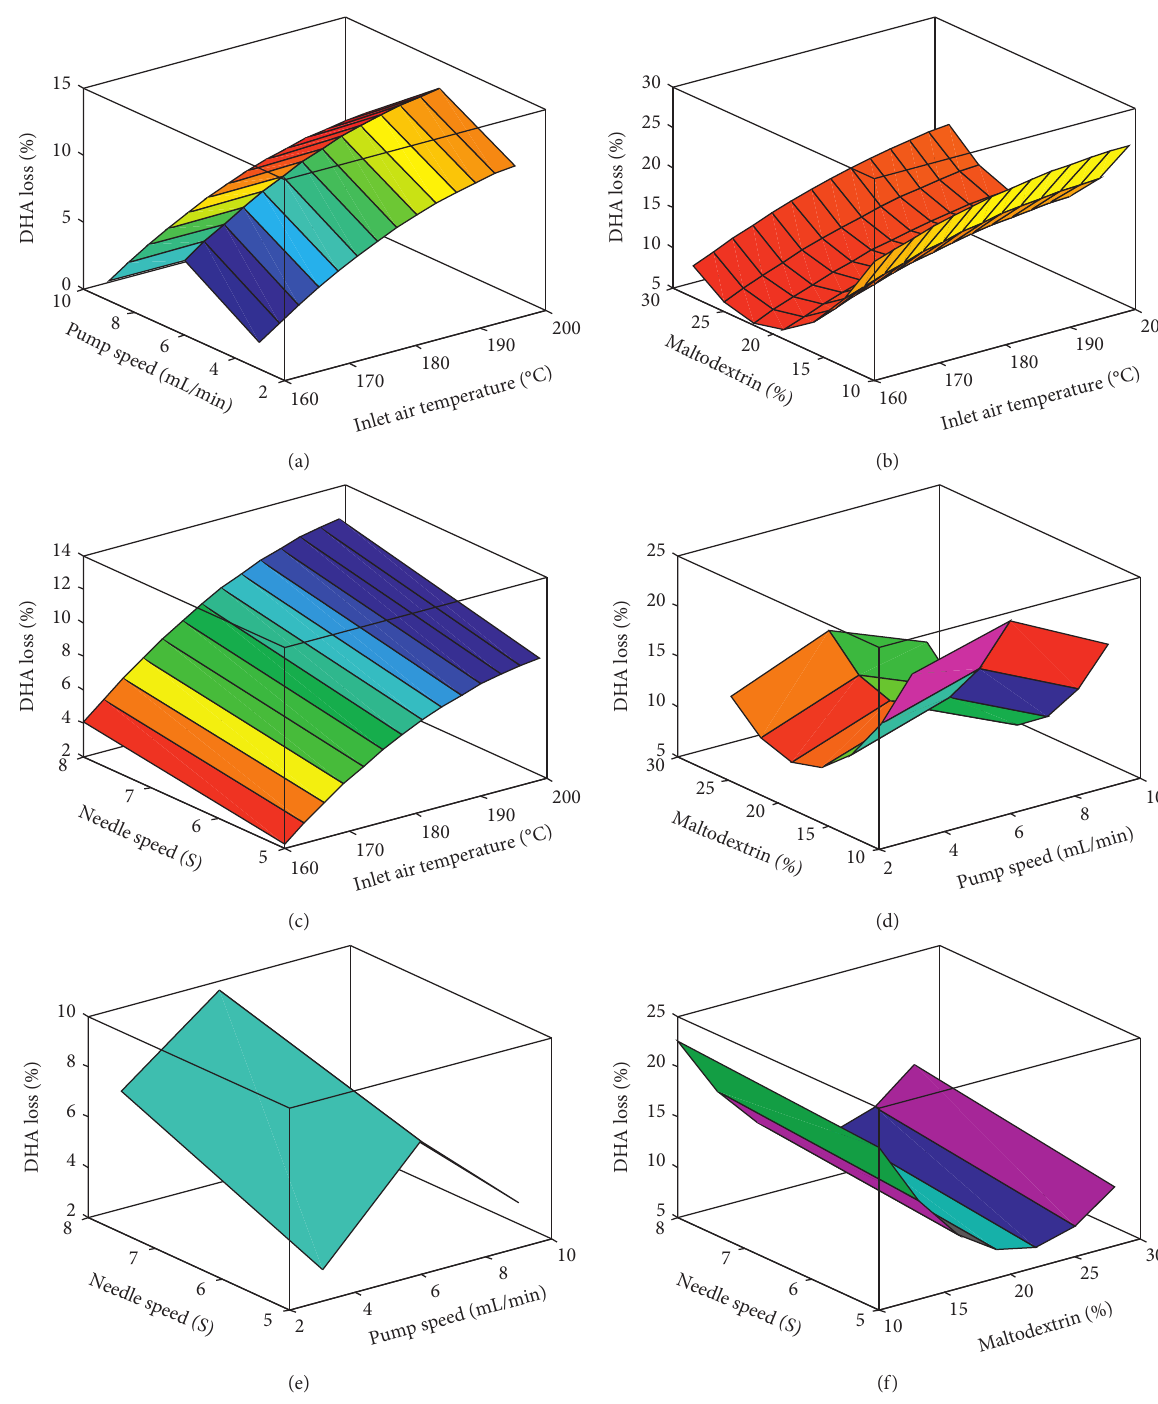
Figure 4: The interaction impact of spray drying independent parameters on percent DHA